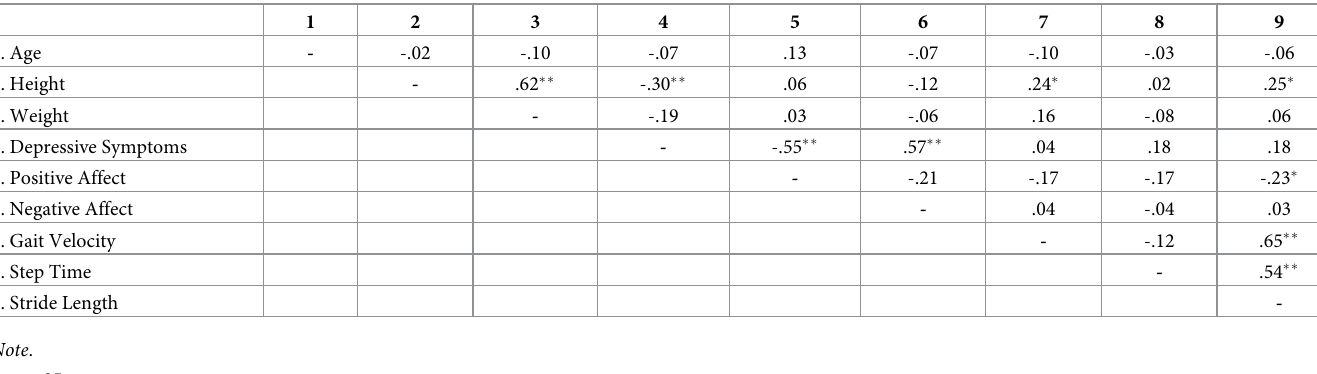
Table 2. Bivariate correlation table for study variables.